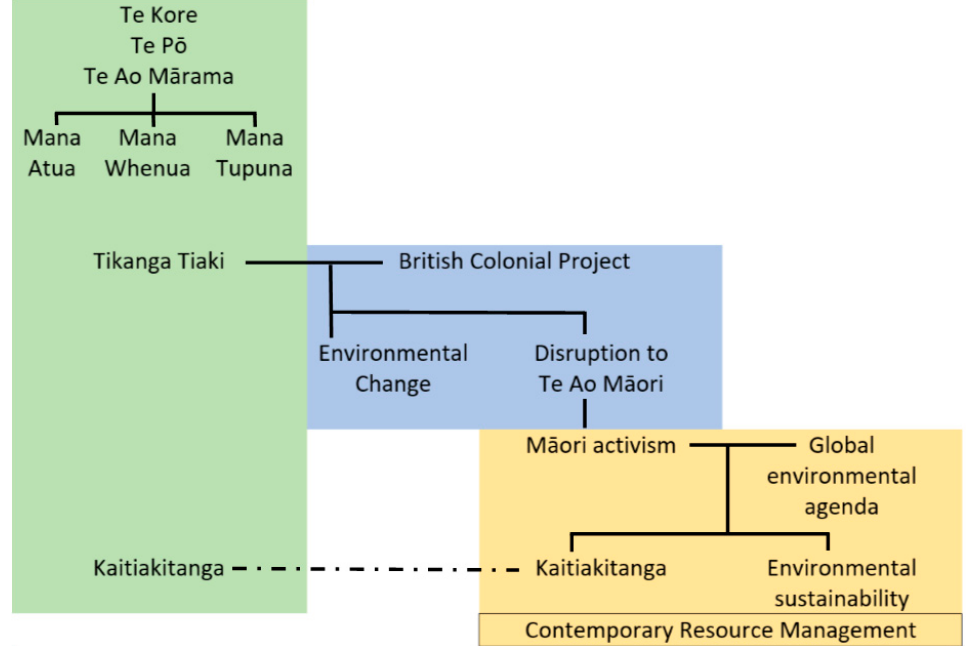
Figure 7. A whakapapa sequence that collates together all three environmental ‘era’—Te Ao M ā ori (green segment), Te Ao Hurihuri (blue segment) and Te Ao Tautohe (yellow segment). Te Ao Tautohe whakapapa sequences emphasise the importance of contests for thinking and